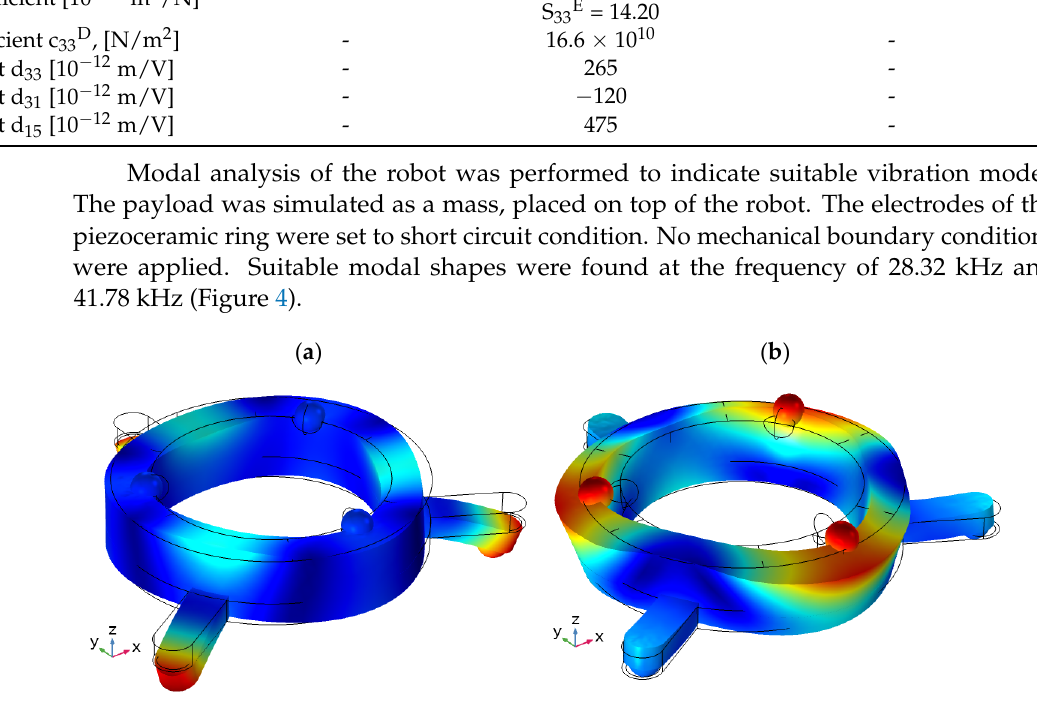
Figure 4. Modal shapes of the robot at the frequency of 28.32 kHz ( a ) and 41.78 kHz ( b ) were used for planar and angular motion, respectively .